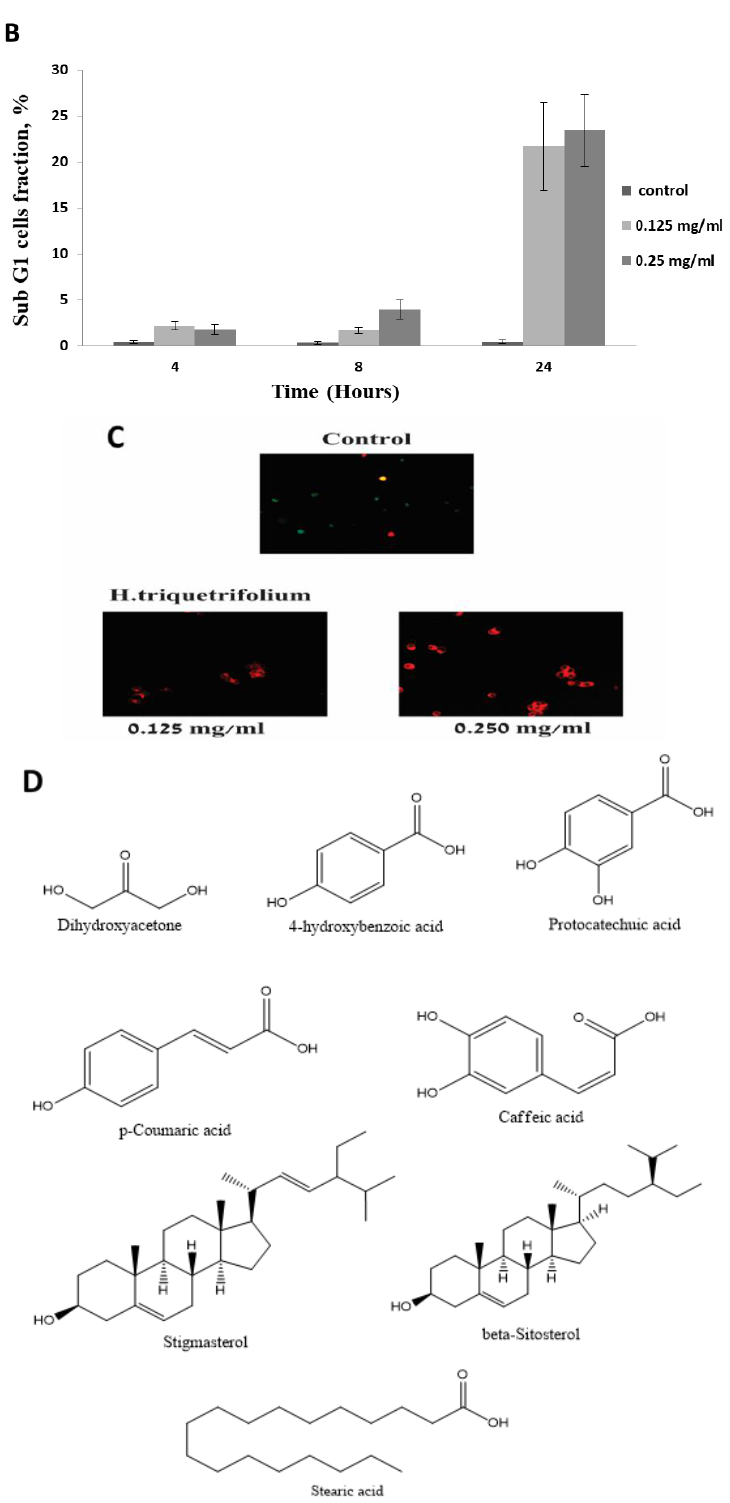
Figure 5. The effect of HTE on cell cycle distribution of HCT-116 cells. ( A ) Cellular DNA was stained with propidium iodide and flow cytometric analysis was done to determine the cell cycle distribution post-treatment with HTE for 4, 8, and 24 h. ( B ) The apoptotic fraction, the sub G1 phase of the cell cycle, is represented on the histograms. ( C ) Fluorescence images of HCT-116 cells using FUCCI Cell Cycle Sensor. Cells were treated with 0.125 and 0.25 mg/mL of HTE for 24 h. Three critical phases can be observed in FUCCI: G0/G1 (Red), G1/S (yellow), and G2/M (Green). ( D ) Chemical structure of the detected putative cell cycle arrest compounds.